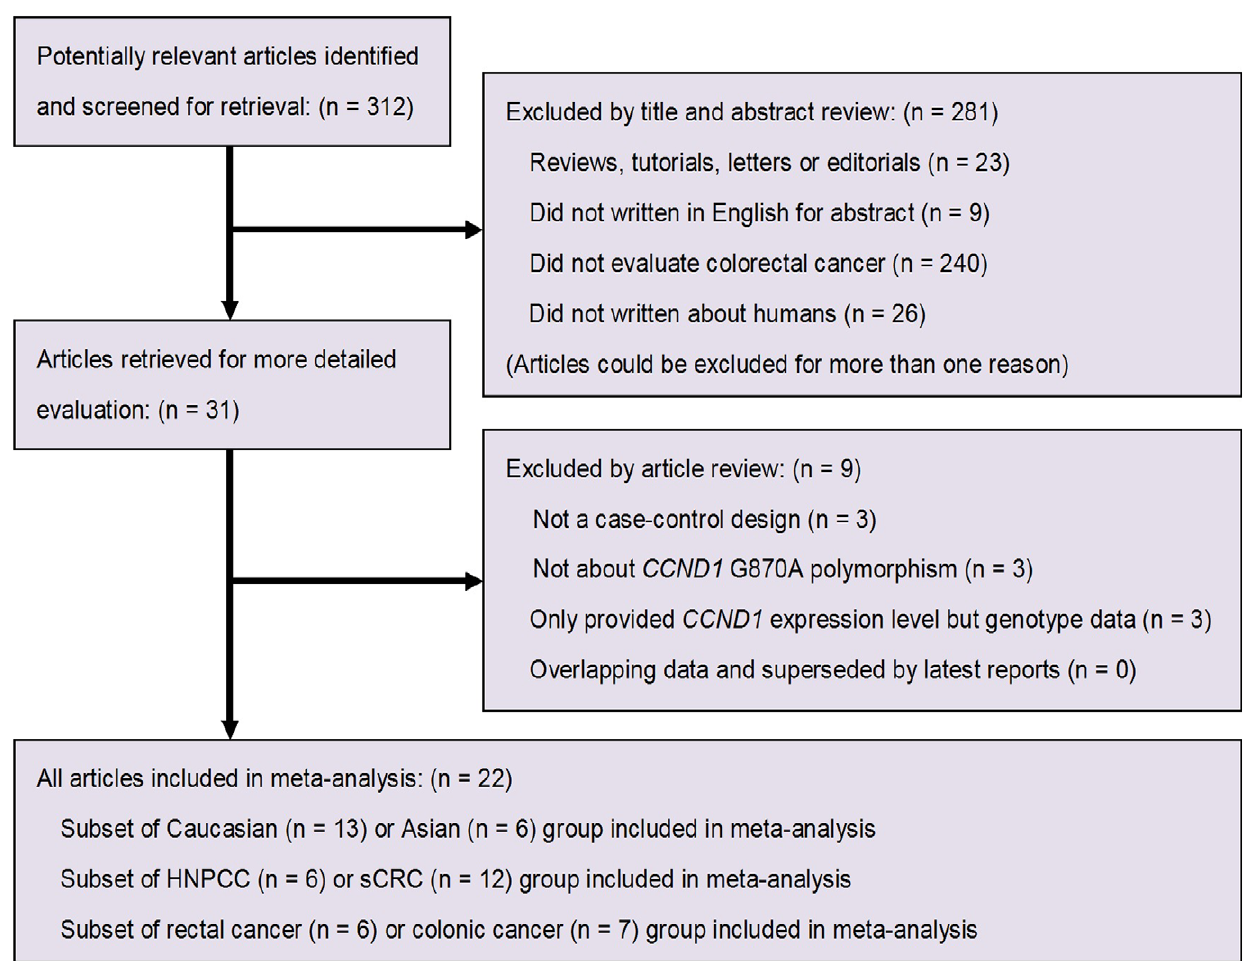
Figure 1. Flow chart of study selection according to MOOSE guidelines [ 42 ] .